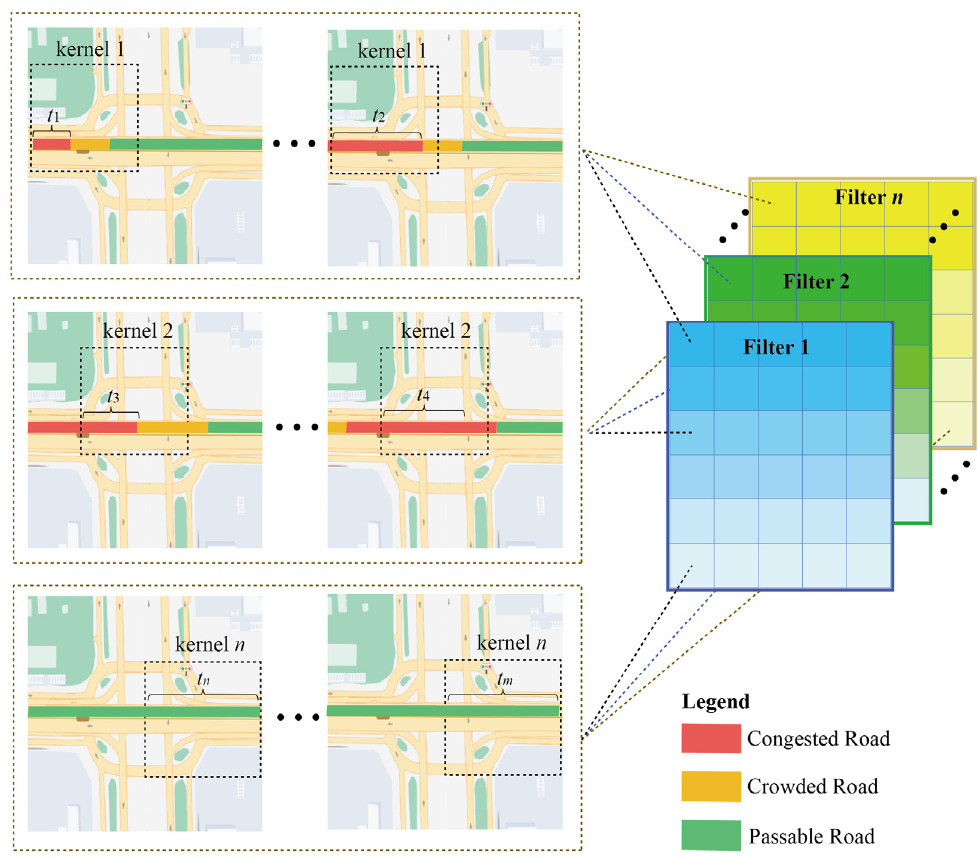
Figure 2. Intrinsic correlation and redundancy of spatiotemporal features.